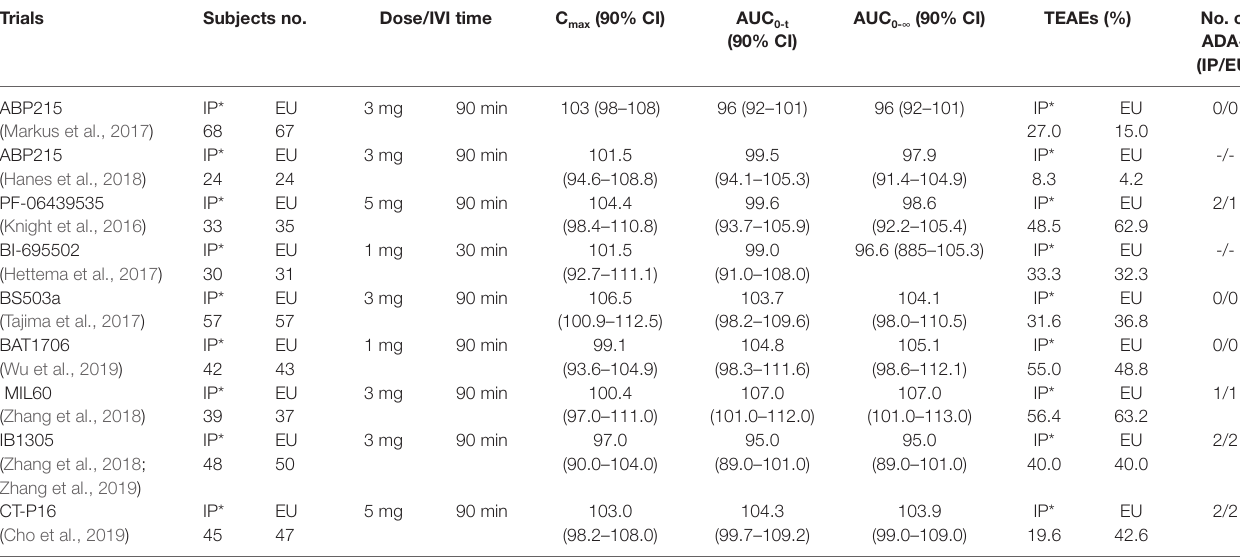
TABLE 5 | Comparison of bevacizumab biosimilar and Avastin ® phase I clinical trials. Trials